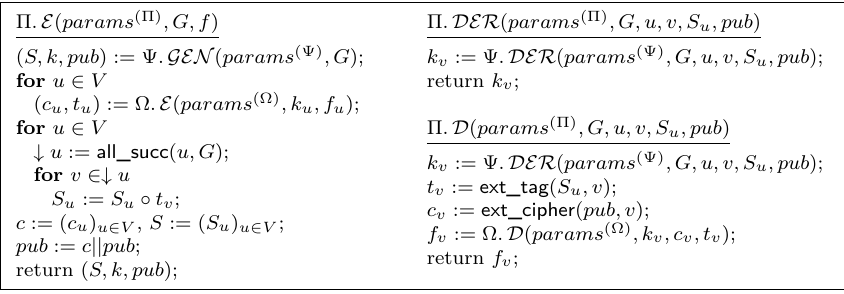
Figure 8: A Framework for building a KAS-AE scheme from KAS and AE schemes, used